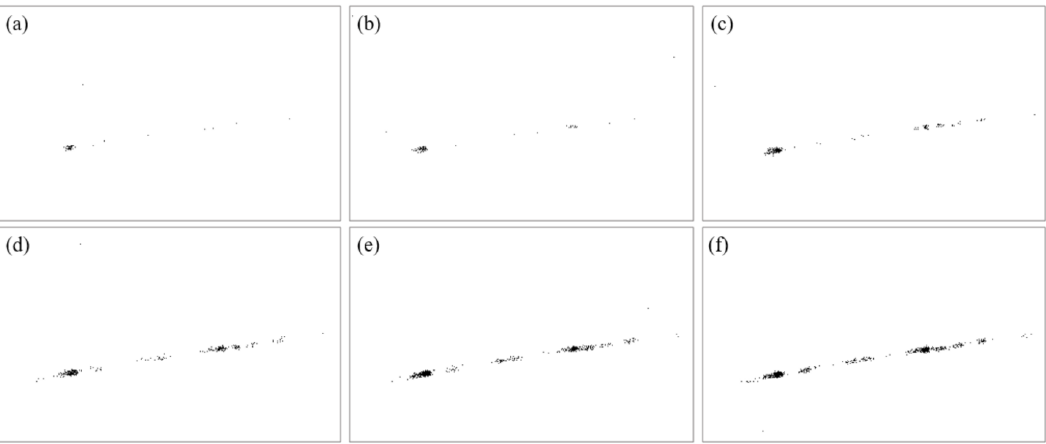
Figure 12. Some representative classified images in the first load cycle: ( a ) 212th; ( b ) 213th; ( c ) 214th; ( d ) 215th; ( e ) 216th; ( f ) 217th.